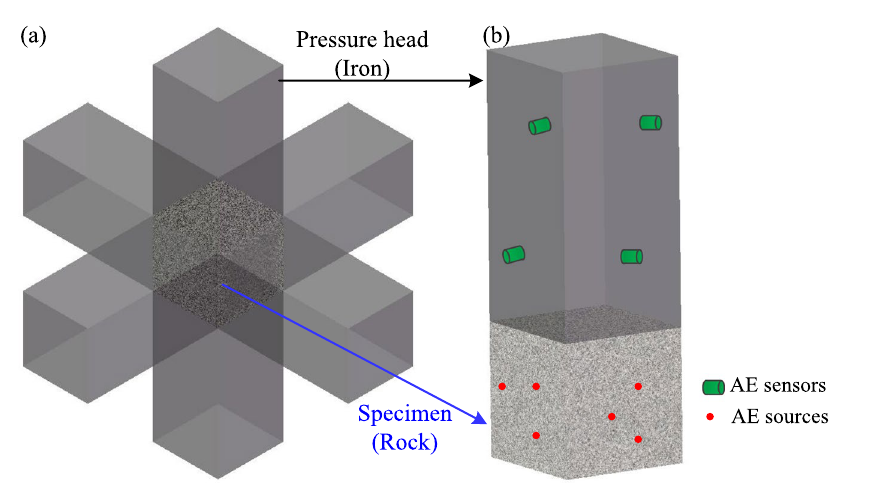
Figure 15. The influence of the distance from the sound source to the refracting surface on location error.